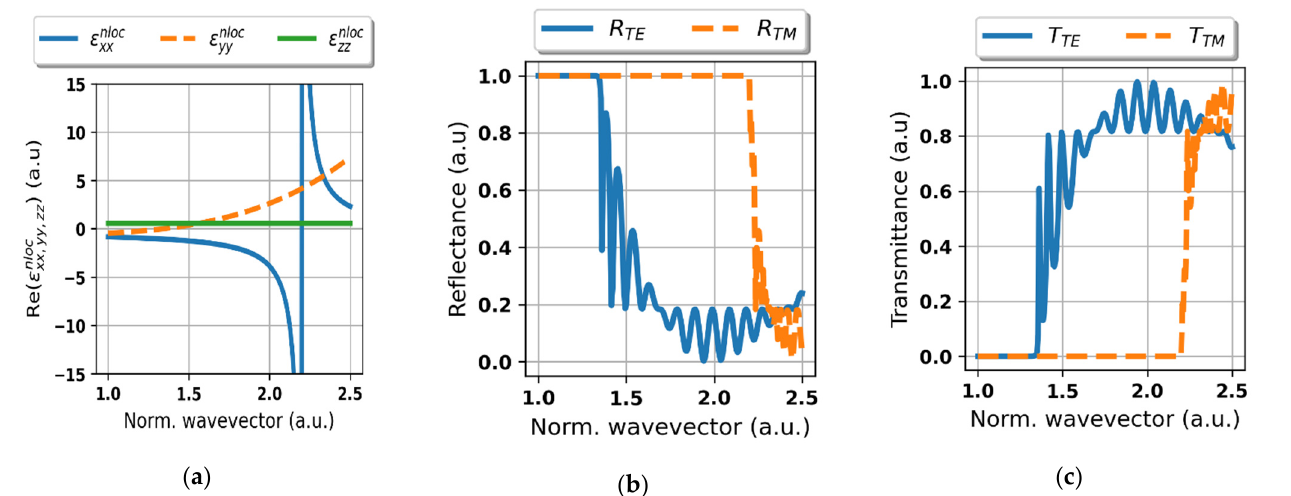
Figure 5. Effective permittivity tensor components ( a ), reflectance ( b ) and transmittance for TE and TM polarization ( c ) of the considered structure plotted vs. wavevector magnitude normalized to the wavevector of free-space wavelength λ = 600 nm at fixed angle of incidence θ inc = 0 ◦ (air-side incidence).